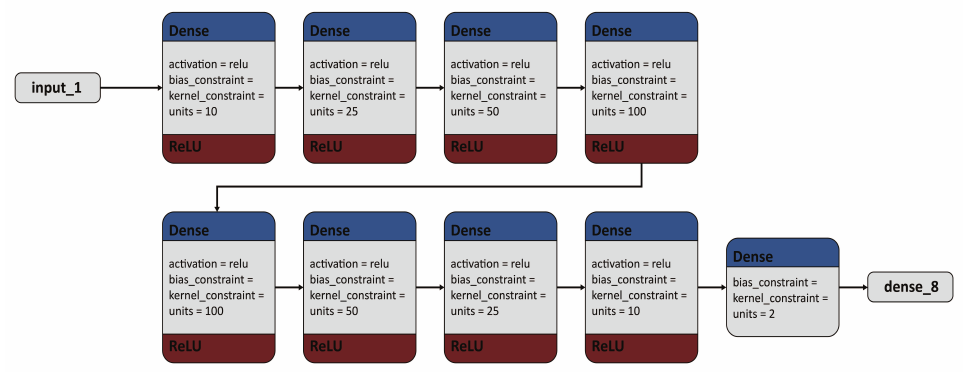
Figure 4. The algorithm of the internal architecture of the dense layers of the ReLU, leaky ReLU, and Swish basic functions applied to analyze the microfluidic parameter